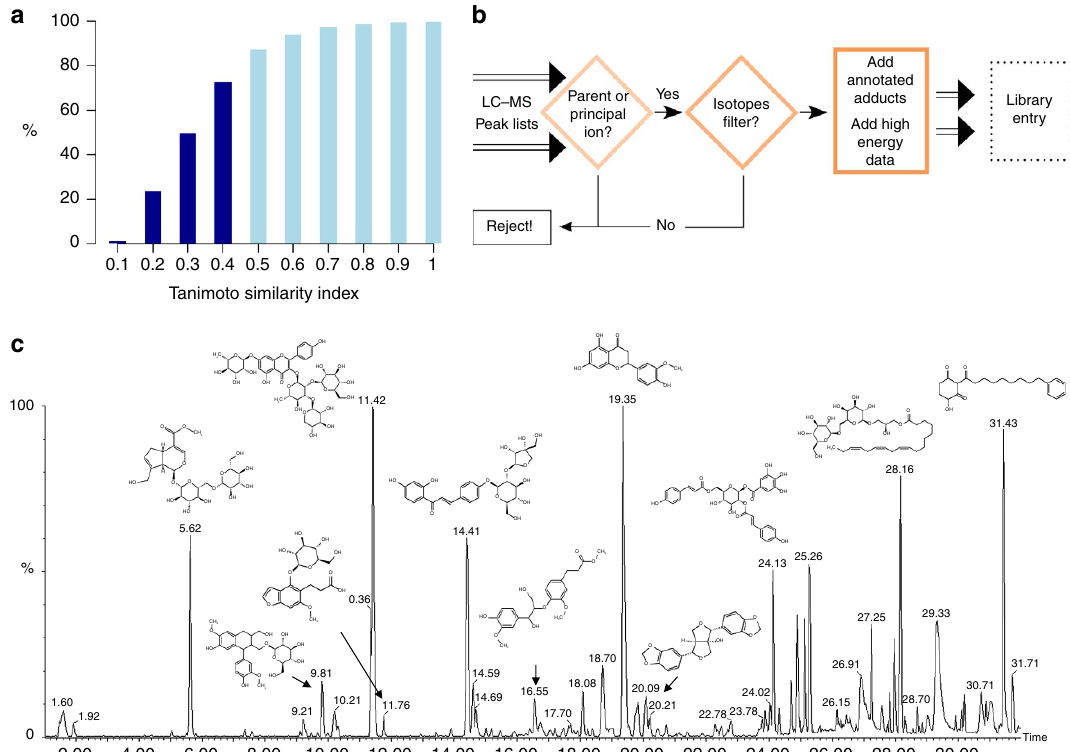
Figure 1 | Generating the WEIZMASS standard-based reference library. ( a ) The diversity of the reference library is summarized by a histogram showing the cumulative Tanimoto similarity index 26 between all library metabolites. Each bar represents the percent of library metabolites pairs having up to the specified Tanimoto similarity index value. As about 50% of the library metabolites have similarity indices lower than 0.3 and over 80% are in the lower than 0.5 range, the library can be considered very structurally diverse. ( b ) An outline of the software which automatically creates the reference library (see Methods section and Supplementary Figs 2 and 3). ( c ) Example chromatogram of a pool of chemical standards analysed by high-resolution MS in the NI mode. The chemical structures of 11 library metabolites are given above the corresponding